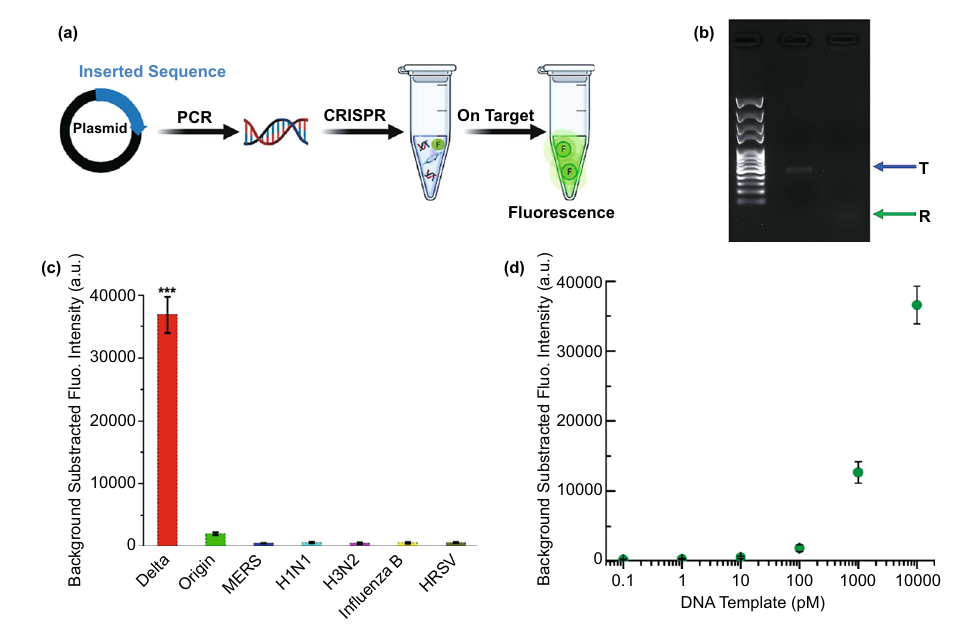
Fig. 2 Feasibility characterization of the CRISPR system. a Streamline the CRISPR reaction. b Validation of trans‑ and cis‑cleavage through agarose gel electrophoresis. c Specificity of the designed crRNA. d Fluorescence‑concentration results, the grey line indicates the limit of detec‑ tion. All the experiments were performed in triplicate, and the significance was presented as ***P <